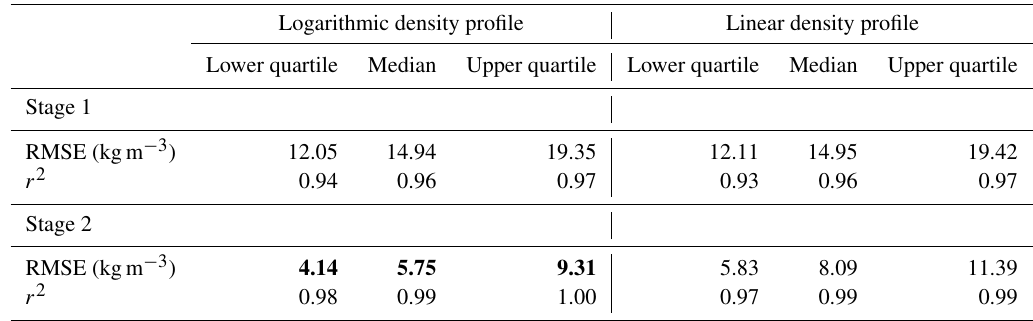
Table B1. Fit statistics. Bold values indicate where the fit to logarithmic density profile is significantly better than using the actual density data based on a two-sample t test ( p < 0 .